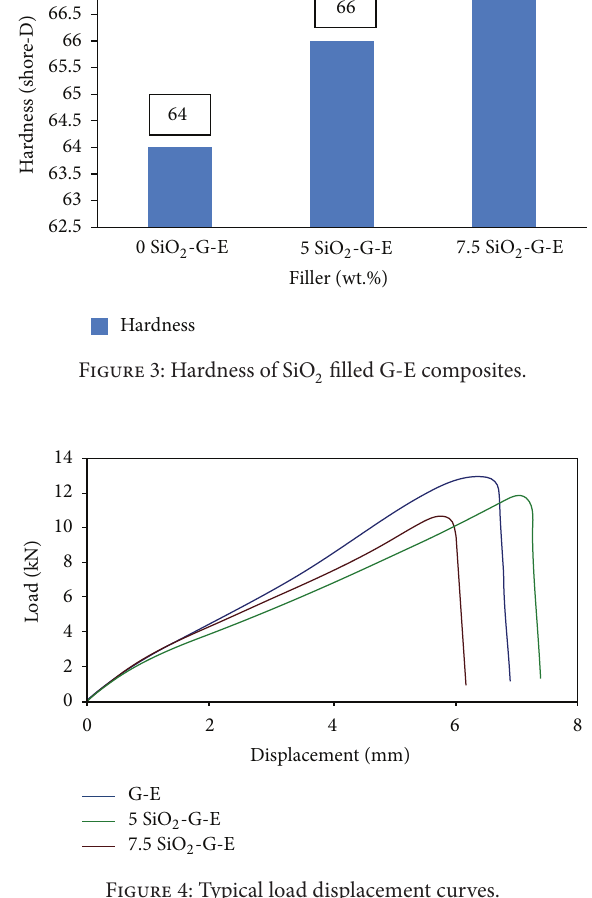
Figure 4: Typical load displacement curves.